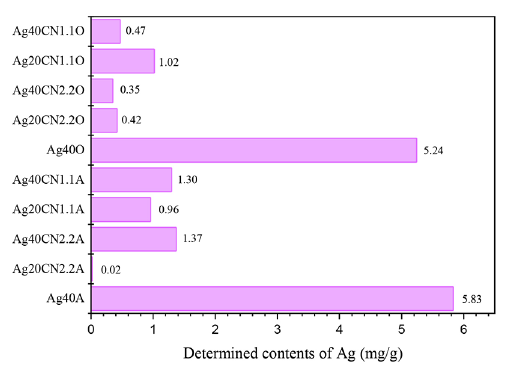
Figure 11. Values of Ag concentrations obtained by AAS on the functionalized BC membranes.